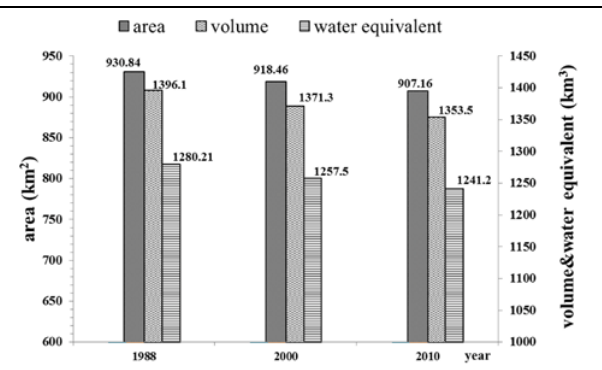
Figure 8. Changes in glacial area (km 2 ), volume (km 3 ) and water equivalent (10 8 m 3 )